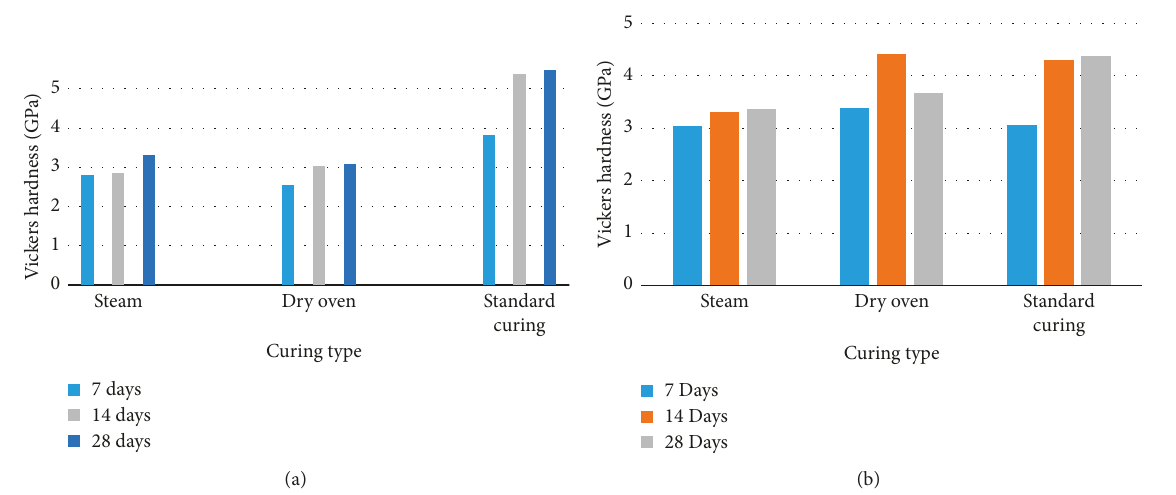
Figure 8: Vickers hardness of concrete specimens with a W/B ratio of 0.35 prepared and cured under different conditions at a temperature of (a) 30 ° C and (b) 50 ° C.